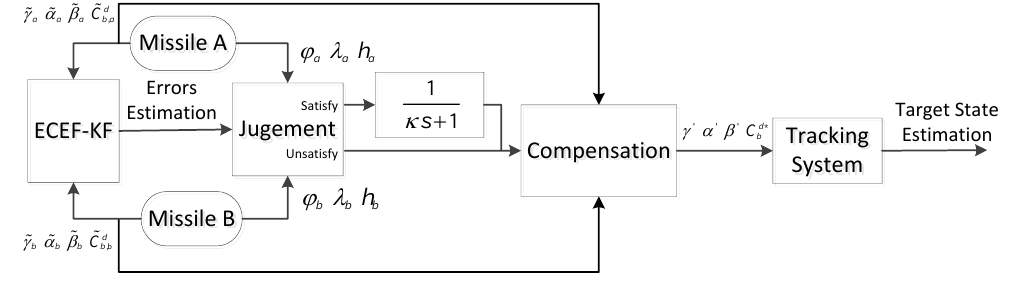
Figure 4. Arcitecture of registration and tracking